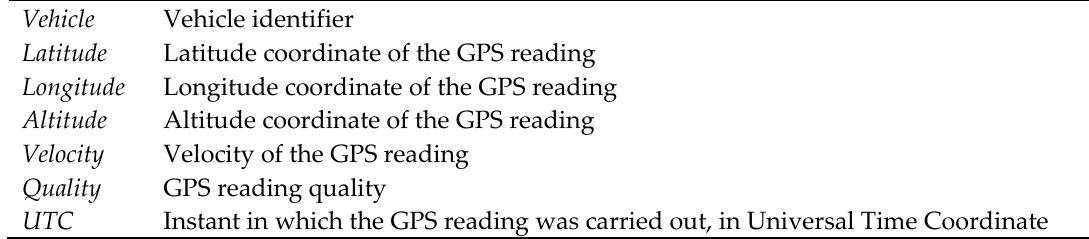
Table 1. Structure of the automatic localization system (AVL)